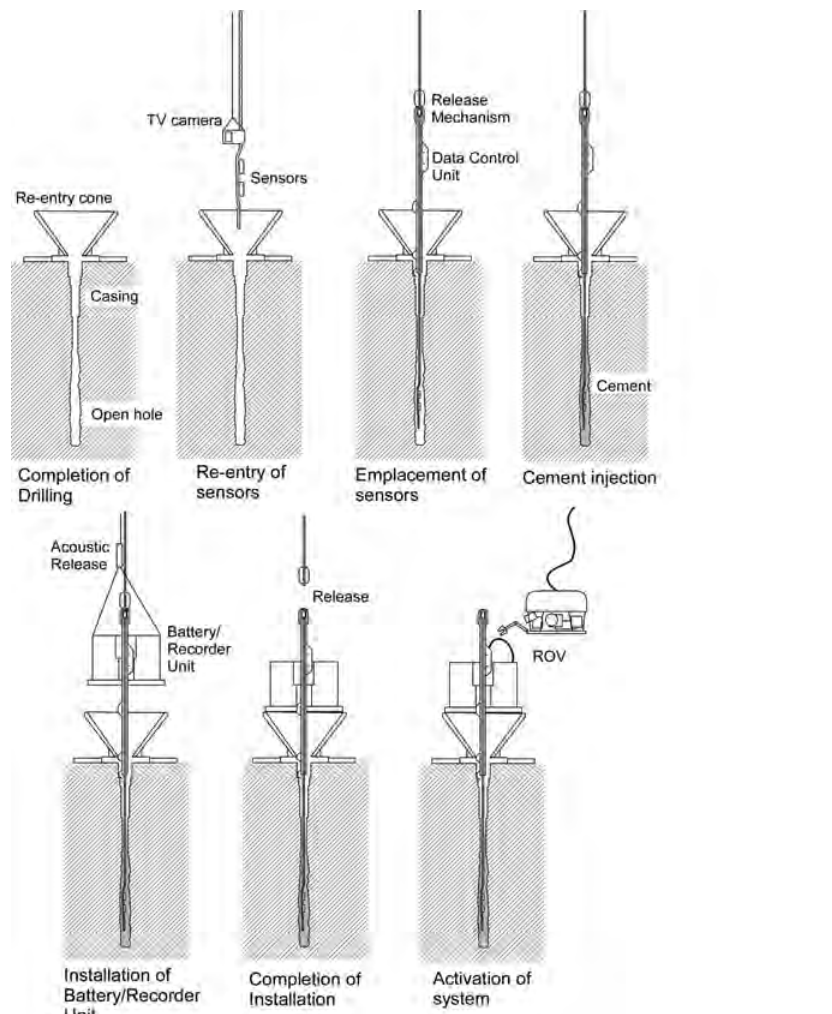
Fig. 4. Installation procedure of the deep-sea borehole broadband seismic observatory. After completion of drilling, the sensor string assembly was lowered into the hole. Because a TV camera was needed for the re-entry of the sen- sor string assembly, the sensors could not be connected to the batteries and data recorder on the seafloor. The cement was displaced down hole for fixing of the sensors. The battery/recorder unit was lowered along the drill string and was released by an acoustic command. After installation, an ROV was used to activate the